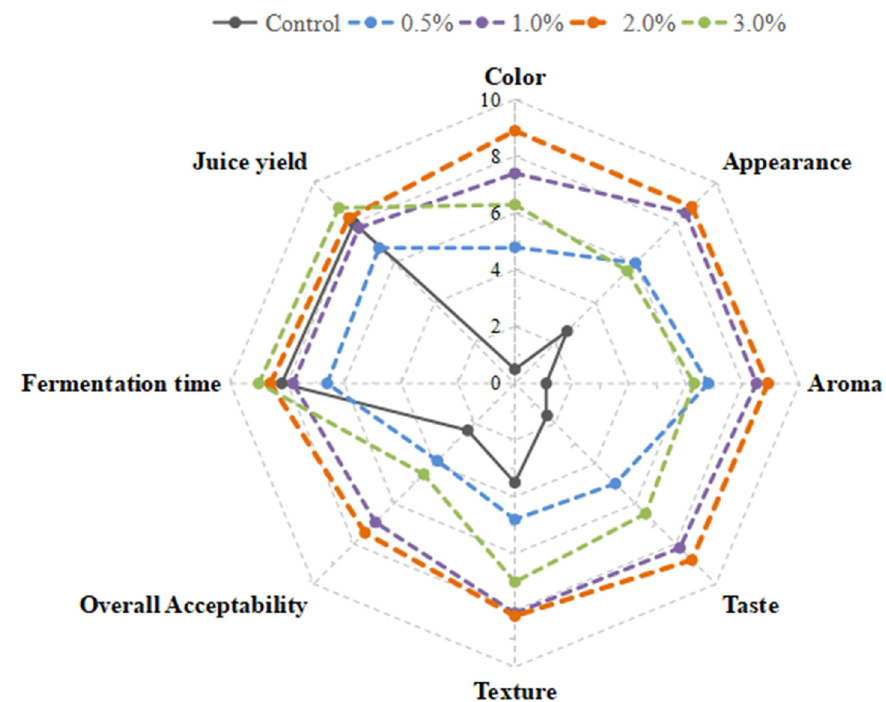
Figure 1. Proportion optimization of the supplementation of Fu brick tea in the fermentation of glutinous rice, analyzed by juice yield, fermentation time, sensory scores of color, appearance, aroma, taste, texture, and overall